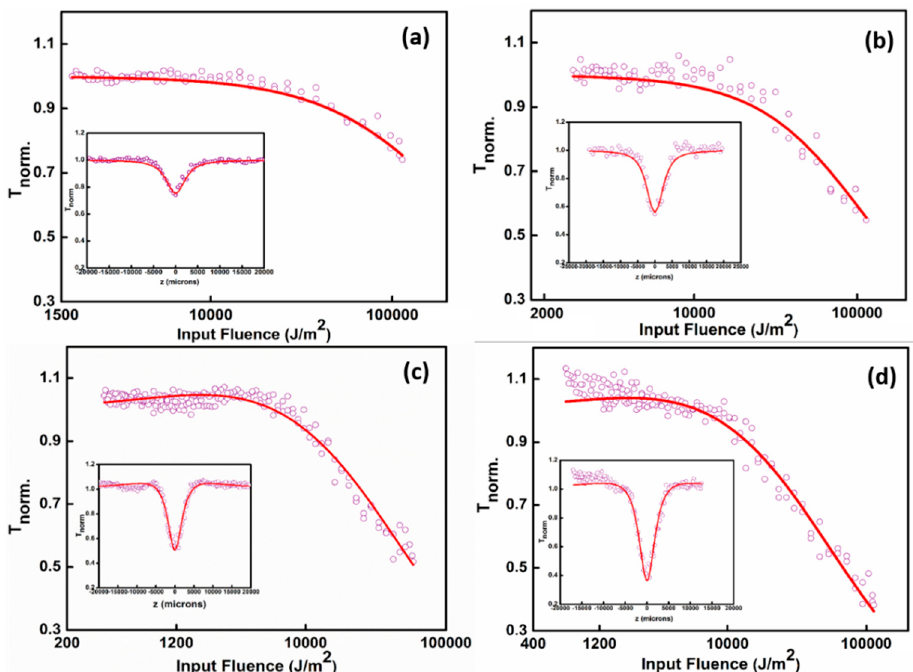
Figure 7. Optical limiting curves of ( a ) Ag NPs, ( b ) GO, ( c ) Ag-GO@355 nm, and ( d ) Ag-GO@532 nm synthesized at the ablation time of 15 min. Laser pulse excitation at a laser pulse energy of 40 µJ. Open circles: data points, solid lines: numerical fits to the corresponding data points.